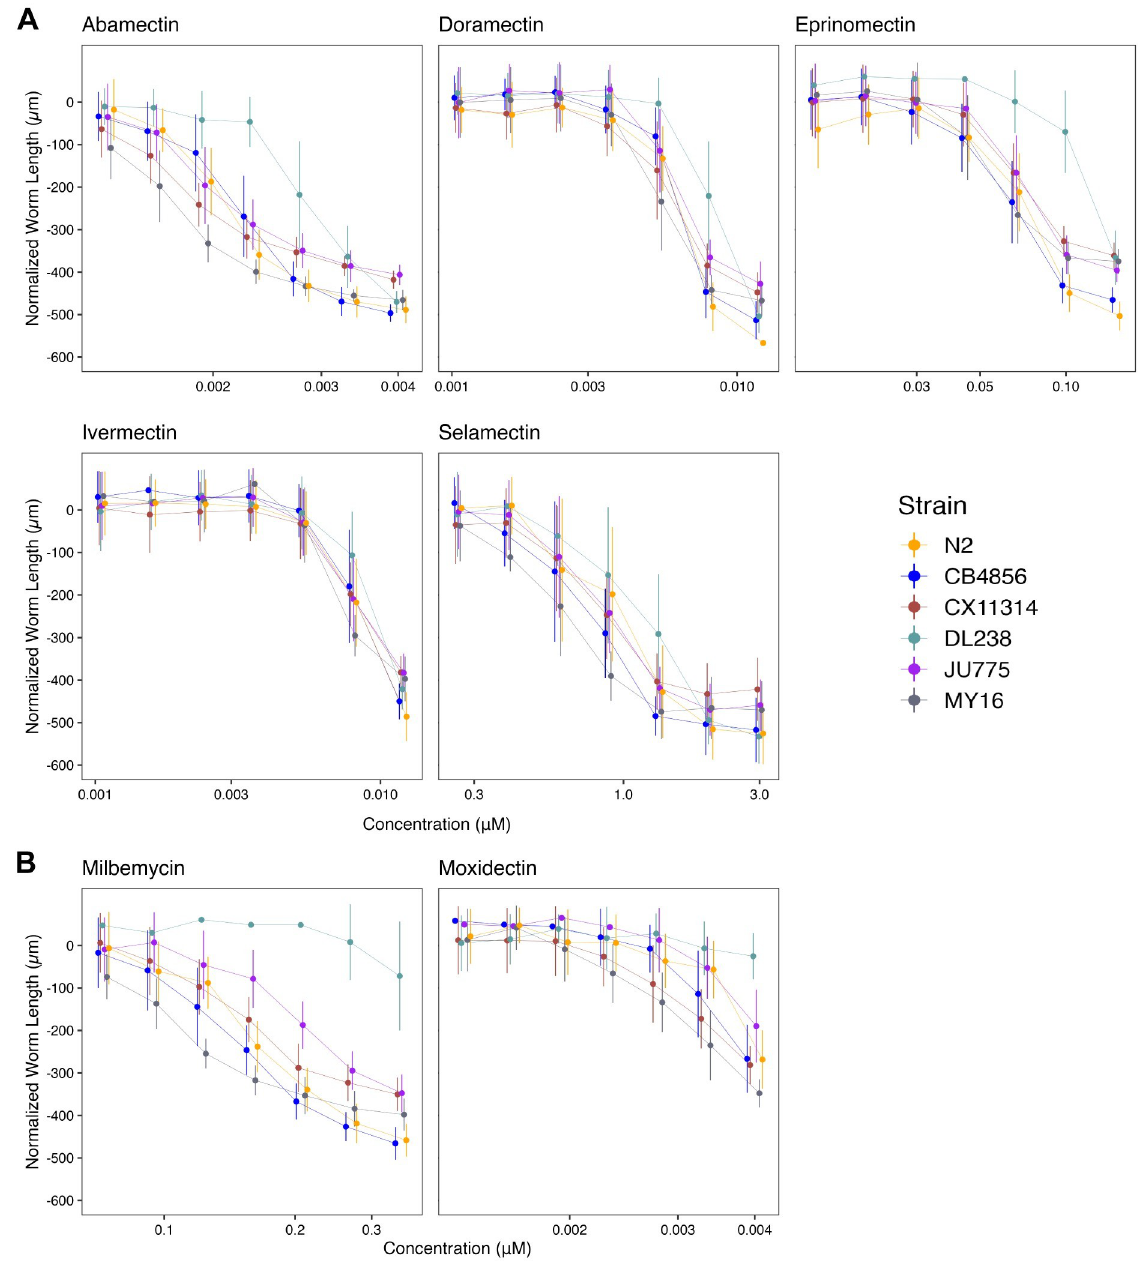
Fig 4. Dose-response curves for macrocyclic lactones (MLs). Normalized animal lengths (y-axis) are plotted for each strain as a function of the dose of macrocyclic lactone supplied in the high-throughput phenotyping assay (x-axis). Macrocyclic lactones are organized by (A) Avermectins: Abamectin, Doramectin, Eprinomectin, Ivermectin, Selamectin; and (B) Milbemycins: Milbemycin and Moxidectin. Strains are denoted by color. Lines extending vertically from points represent the standard deviation from the mean response. Statistical normalization of animal lengths is described in Methods